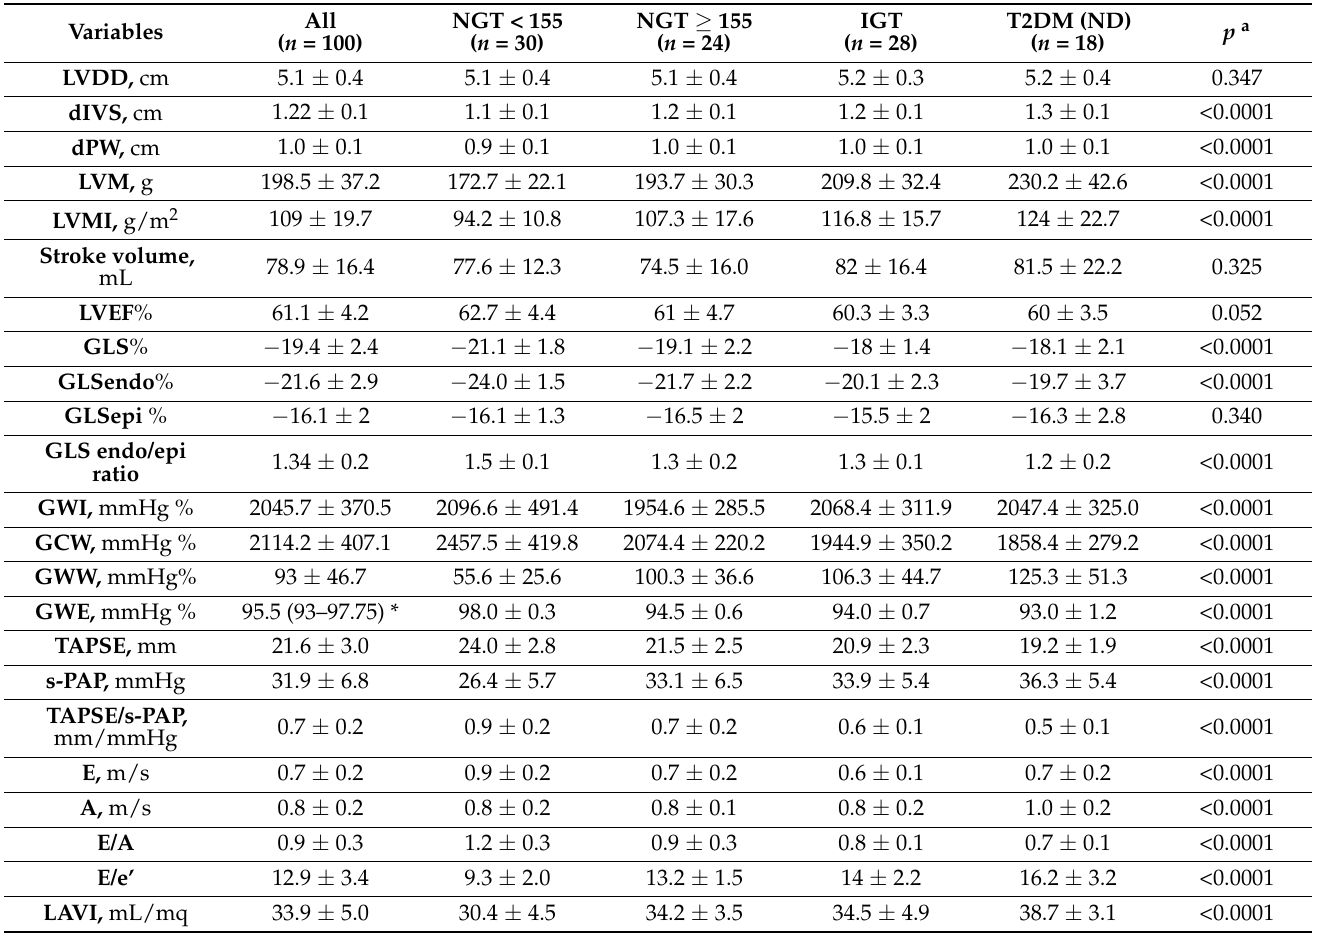
Table 2. Morpho-functional echocardiographic parameters of the study population according to glucose